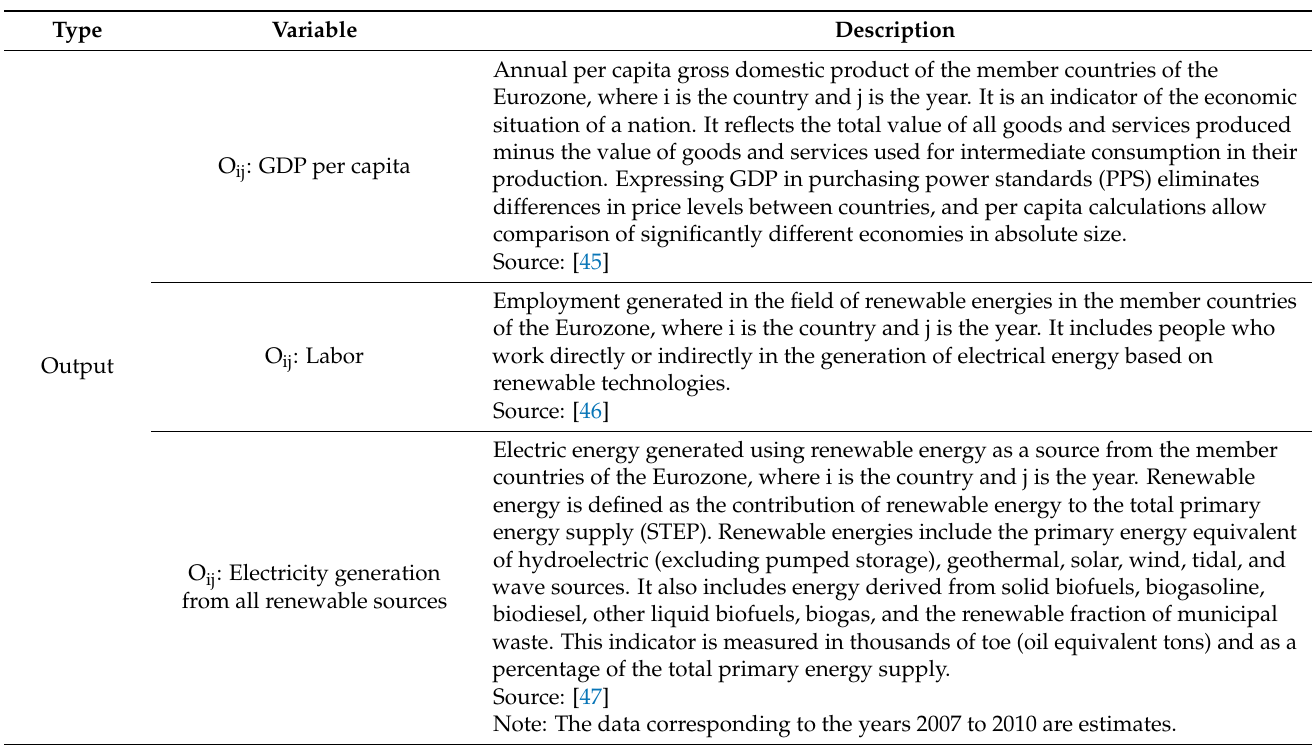
Table 2. Production function of the degree of environmental